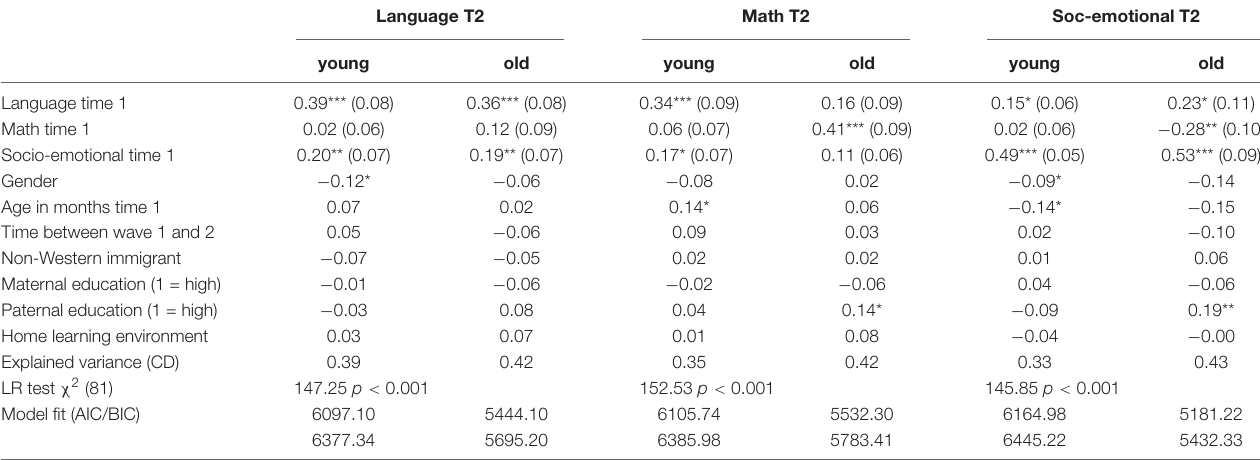
TABLE 5 | Standardized regression coefficients of the path analyses for younger ( N = 310) and older ( N = 267)